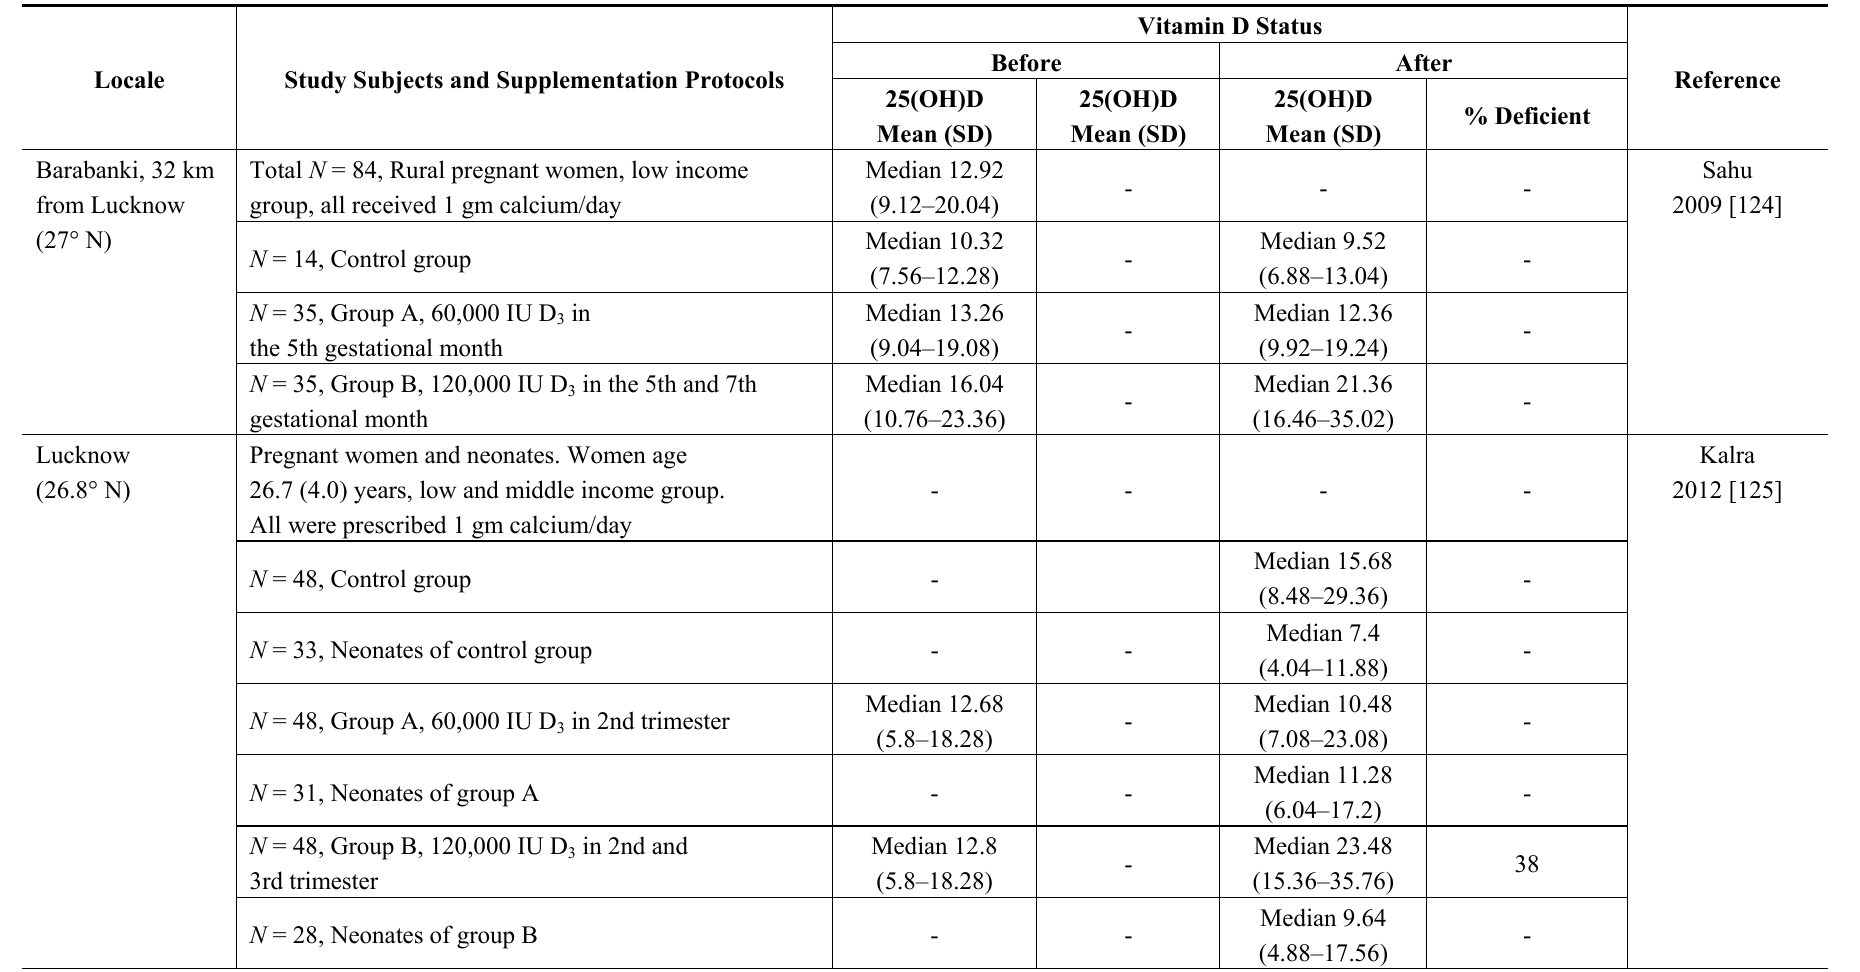
Table 3. Vitamin D supplementation studies in ostensibly healthy Indians. All 25(OH)D values have been shown in ng/mL. To convert from nM to ng/mL, nM values were divided by (2.5). Vitamin D deficiency is defined as 25(OH)D < 20 ng/mL, insufficiency as 20–29 ng/mL and sufficiency as ≥ 30 ng/mL. ‡ Information available from the abstract of the article. D elemental calcium. Age of the subjects is in mean age (SD) years, unless otherwise